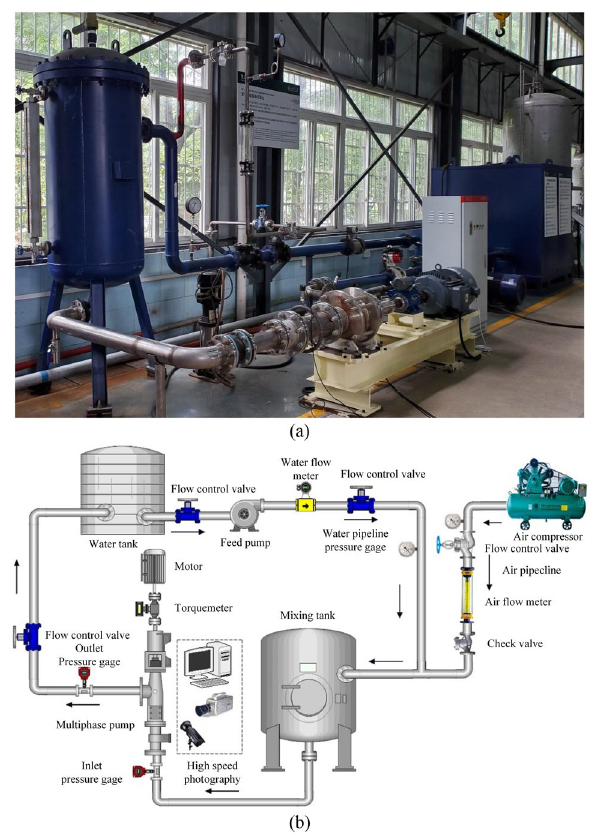
Figure 4. Test system of the multiphase equipment. ( a ) Photograph of the test system and ( b ) schematic of the test system.